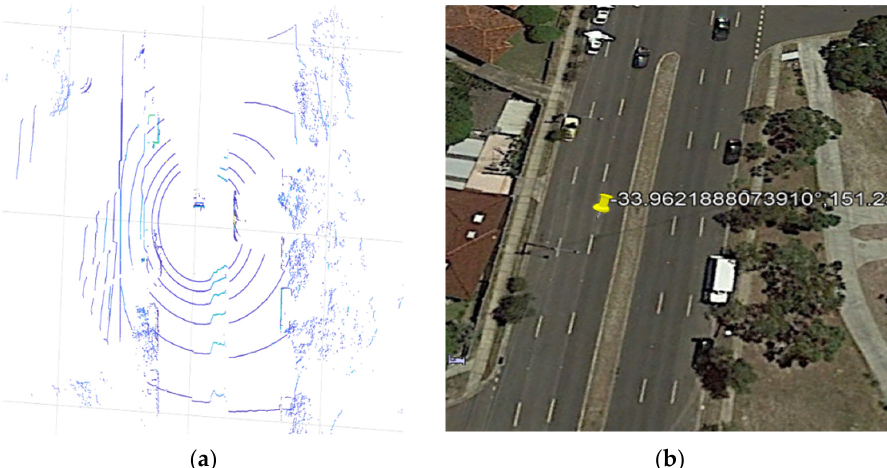
Figure 19. Scan frame at epoch 40,888 s with big outlier in Trajectory Section 2, an opposite driving vehicle detected, ( a ) Lidar scan; ( b ) Google Earth view.